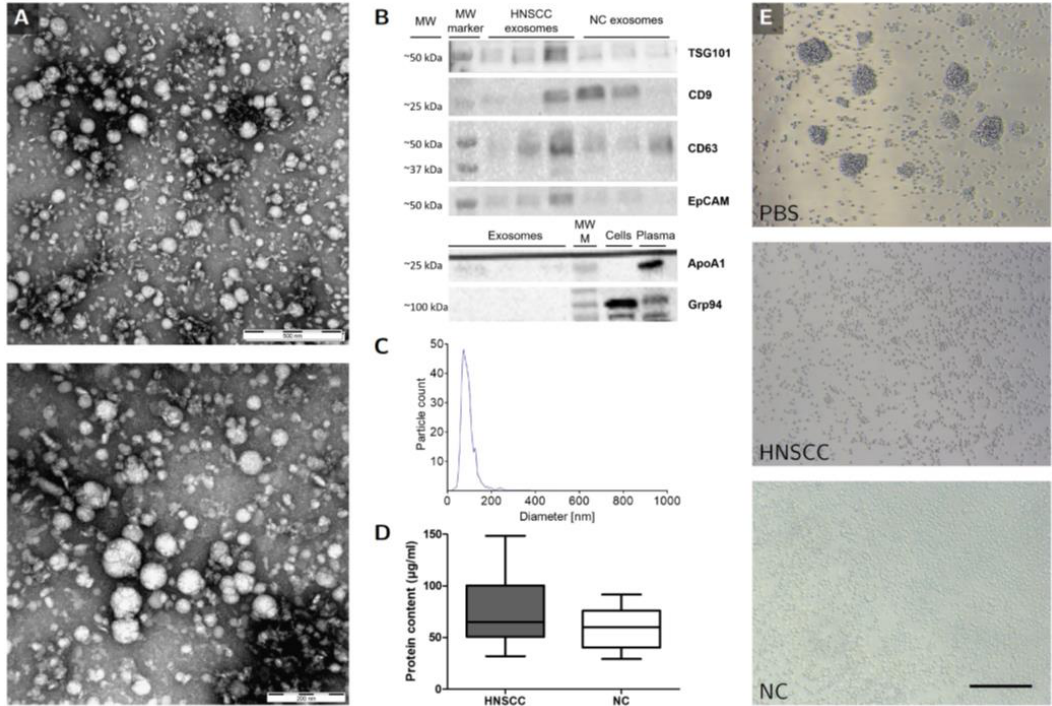
Figure 2. Successful isolation of exosomes from blood plasma was verified by Transmission Electron Microscopy (TEM), Western Blot, and Nanoparticle tracking. ( A ) Two representative TEM graphs showing negatively stained exosomes isolated from an HNSCC patient. As indicated by the size bars, exosomes vary in diameter between 30 and 150 nm and have round to oval shapes. Size bar on the top TEM graph = 500 nm, size bar on the bottom TEM graph = 200 nm. ( B ) Western Blot analysis of exosomes was performed to confirm the expression of exosomal markers TSG101, CD9 and CD63 and the expression of epithelial cell marker EpCAM (upper frame). Exosomes were also analyzed for negative markers ApoA1 and Grp94 along with plasma (diluted 50 × in PBS) and cell lysate samples as positive controls. MW marker, positive control molecular weight marker. ( C ) Size distribution of exosomes was measured by nanoparticle tracking. The mean diameter was 86.8 nm. The maximal and minimal diameters were 257.5 nm and 22.5 nm, respectively. The 90th and 10th percentile were at 121.2 and 53.6 nm, respectively. ( D ) Protein content of exosomes was determined by Bicinchoninic Acid (BCA) Assay. Average protein content: 80.9 g / mL (HNSCC exosomes), 69.2 g / mL (healthy volunteer exosomes). n = 23 (HNSCC), n = 10 (NC). HNSCC, exosomes from blood plasma of HNSCC patients. NC = no cancer, exosomes from blood plasma of healthy volunteers. ( E ) B cells that were not co-cultured with exosomes exhibited colony formation under the light microscope (top